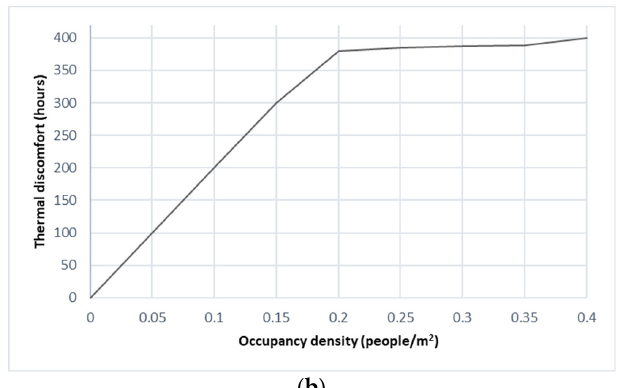
Figure 12. The effect of occupancy density on ( a ) energy consumption and ( b ) students’ thermal discomfort hours.